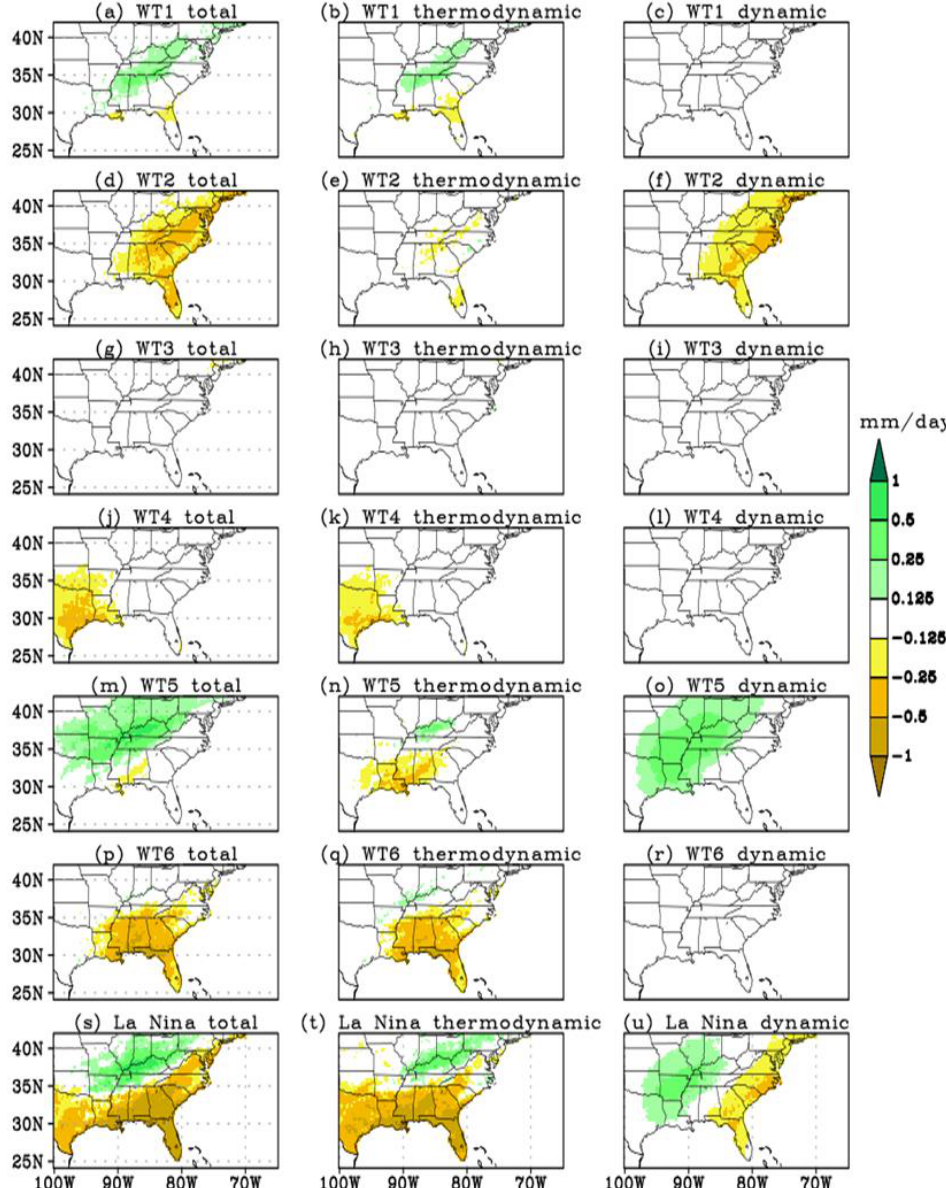
Figure 9. Precipitation anomalies in La Niña years in December–February (panel ( s )). Panels ( a – r ) are the contribution of the WTs 1 – 6 to the anomalous precipitation. Left, middle and right panels are the total, thermodynamic and dynamic contribution from each WT, respectively. Panels ( t , u ) are the sum of thermodynamic and dynamic contribution for all WTs, respectively.